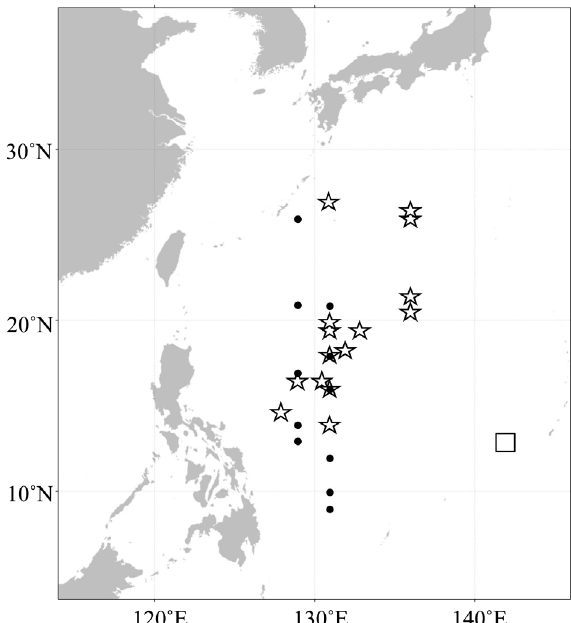
Fig. 1. Map showing collection localities for POMEW samples in 2013 (square), 2014 (closed circle) and 2015 (open star).